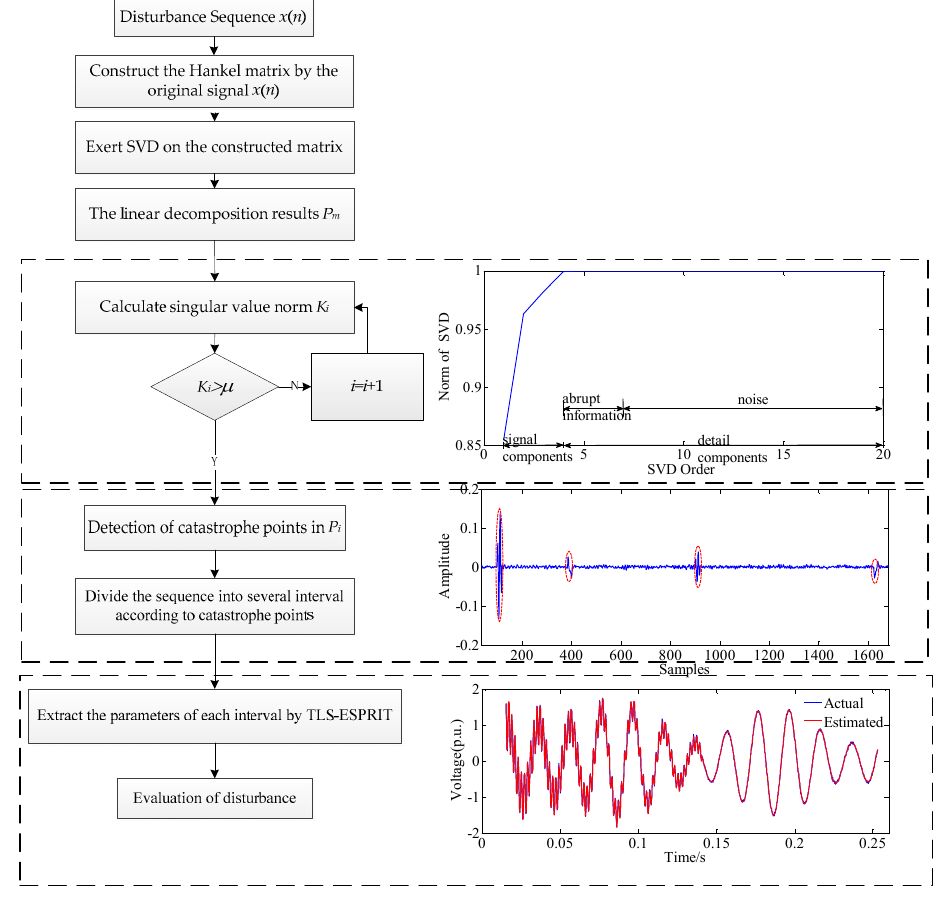
Figure 4. The flowchart for measurement of power quality.